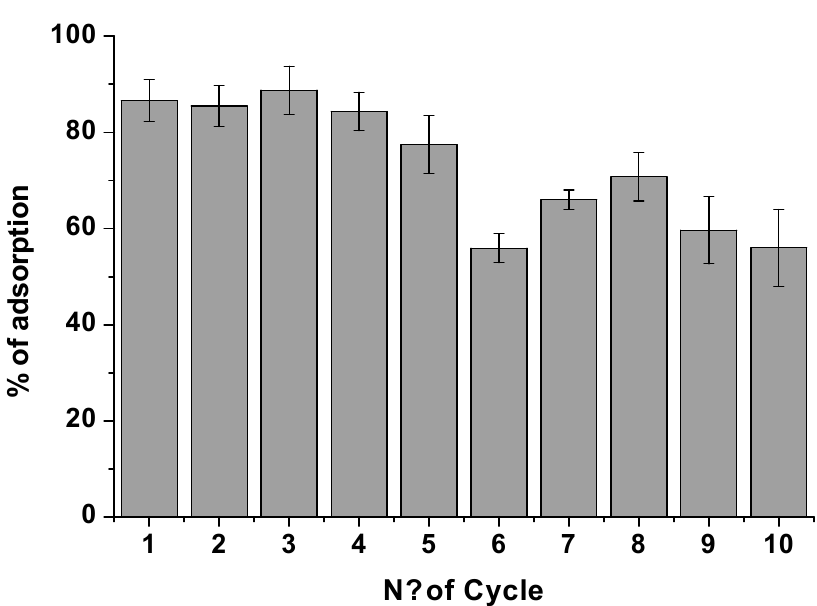
Figure 5. The percentage of DCF adsorption onto chitosan film (Film 2), at pH 5, (from a DCF solution 1.50 × 10 − 5 M), calculated for 10 consecutive cycles of adsorption by using the same film and by changing the DCF solution after each cycle. The contact time for each cycle was 120 min.